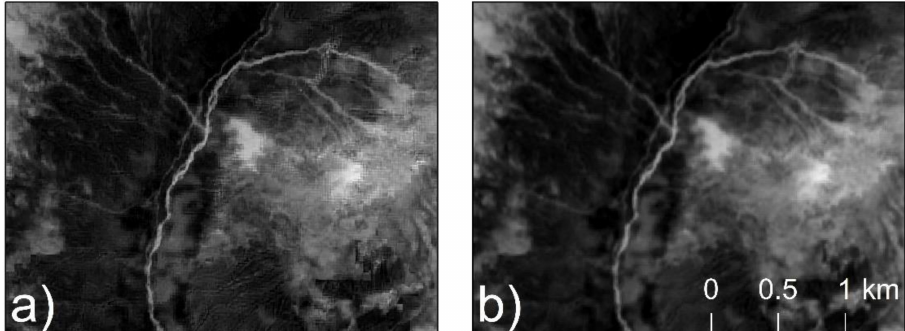
Figure 4. Salt-and-pepper noise removal using smooth filtering. ( a ) MNDWI before smoothing. ( b ) MNDWI after